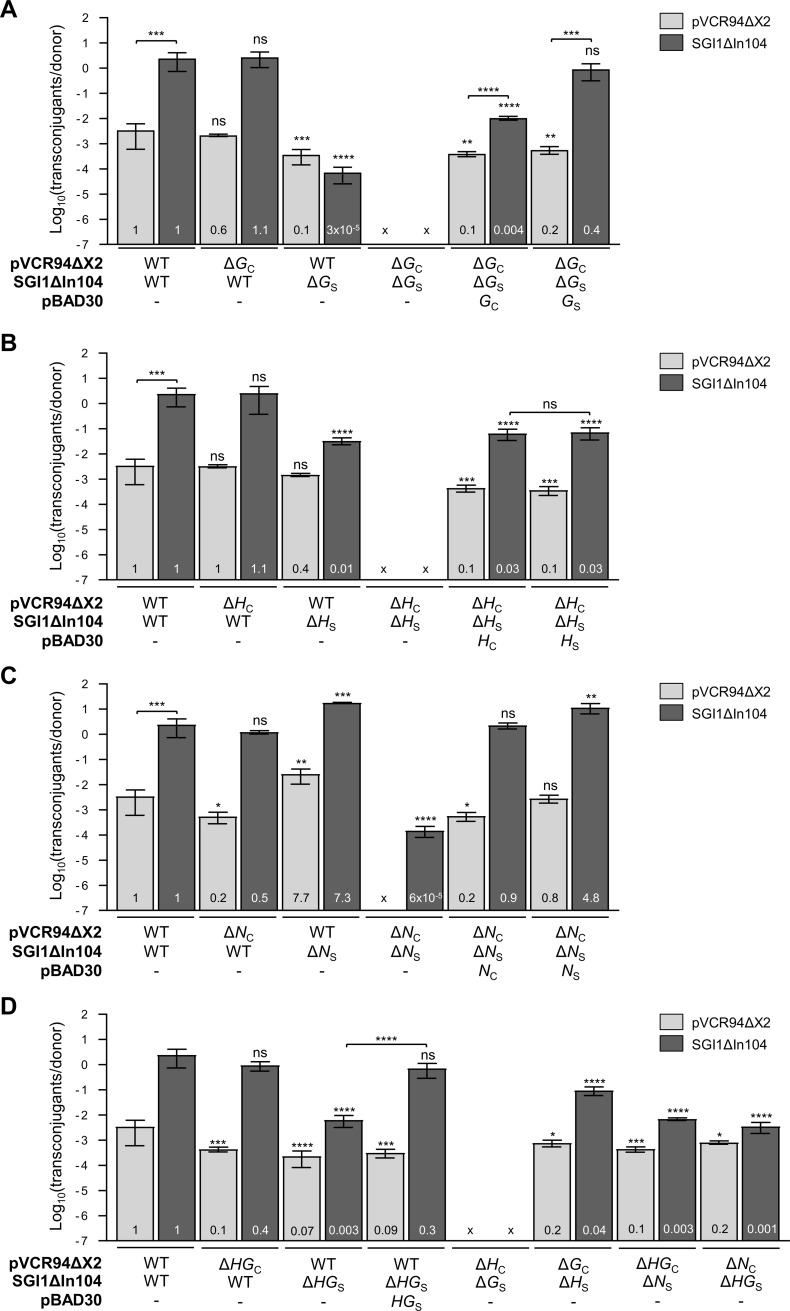
Role of traC and traS genes on conjugative transfer of IncC plasmids and SGI1.(A) Effect of traGC and traGS on conjugative transfer of pVCR94ΔX2 (light gray bars) and SGI1ΔIn104 (dark gray bars). (B) Effect of traHC and traHS. (C) Effect of traNC and traNS. (D) Effect of combinatory deletions. For details, refer to legend of Fig 3. Two one-way ANOVA with Tukey’s multiple comparison test were carried out separately for each element. The unpaired t-test (two-tailed) was performed to compare the bars of different elements. WT frequencies of transfer for both elements come from a single set of experimental replicates but are displayed throughout panels A to D as a reference in each statistical analysis.